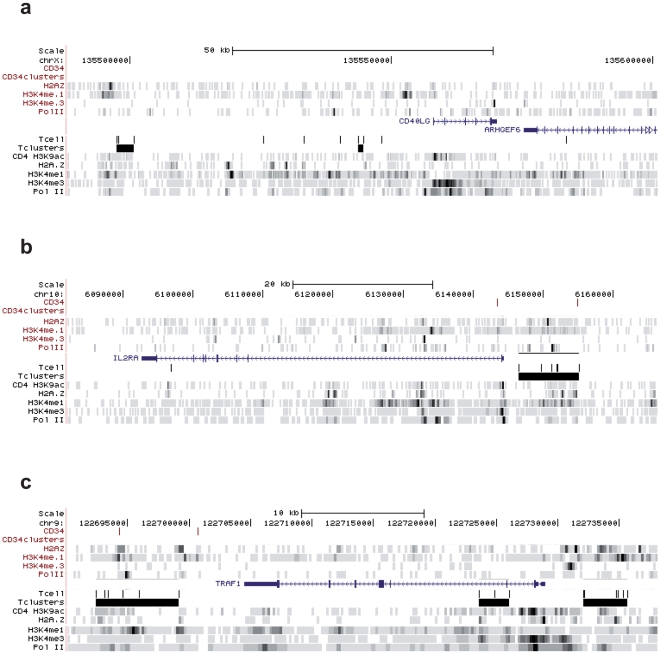
MLV integration clusters in T cell-specific loci.Distribution of MLV integrations (black bars for T cells and red bars for CD34+ hematopoietic progenitor cells), and clusters (black boxes for T cell and red boxes for CD34+ cells), within three RefSeq gene loci (CD40LG, IL2RA, TRAF1) specifically expressed in T cells, as displayed by the UCSC genome browser. H2A.Z, H3K4me1, H3K4me3, H3K9ac and Pol II tracks are those determined by ChIP-seq in the genome of human CD34+/CD133+ HPCs [36] (in red, above the gene) and in human primary T cells [20] (in black, below the gene). Blue boxes represent exons, arrowheads in introns indicate the direction of transcription.